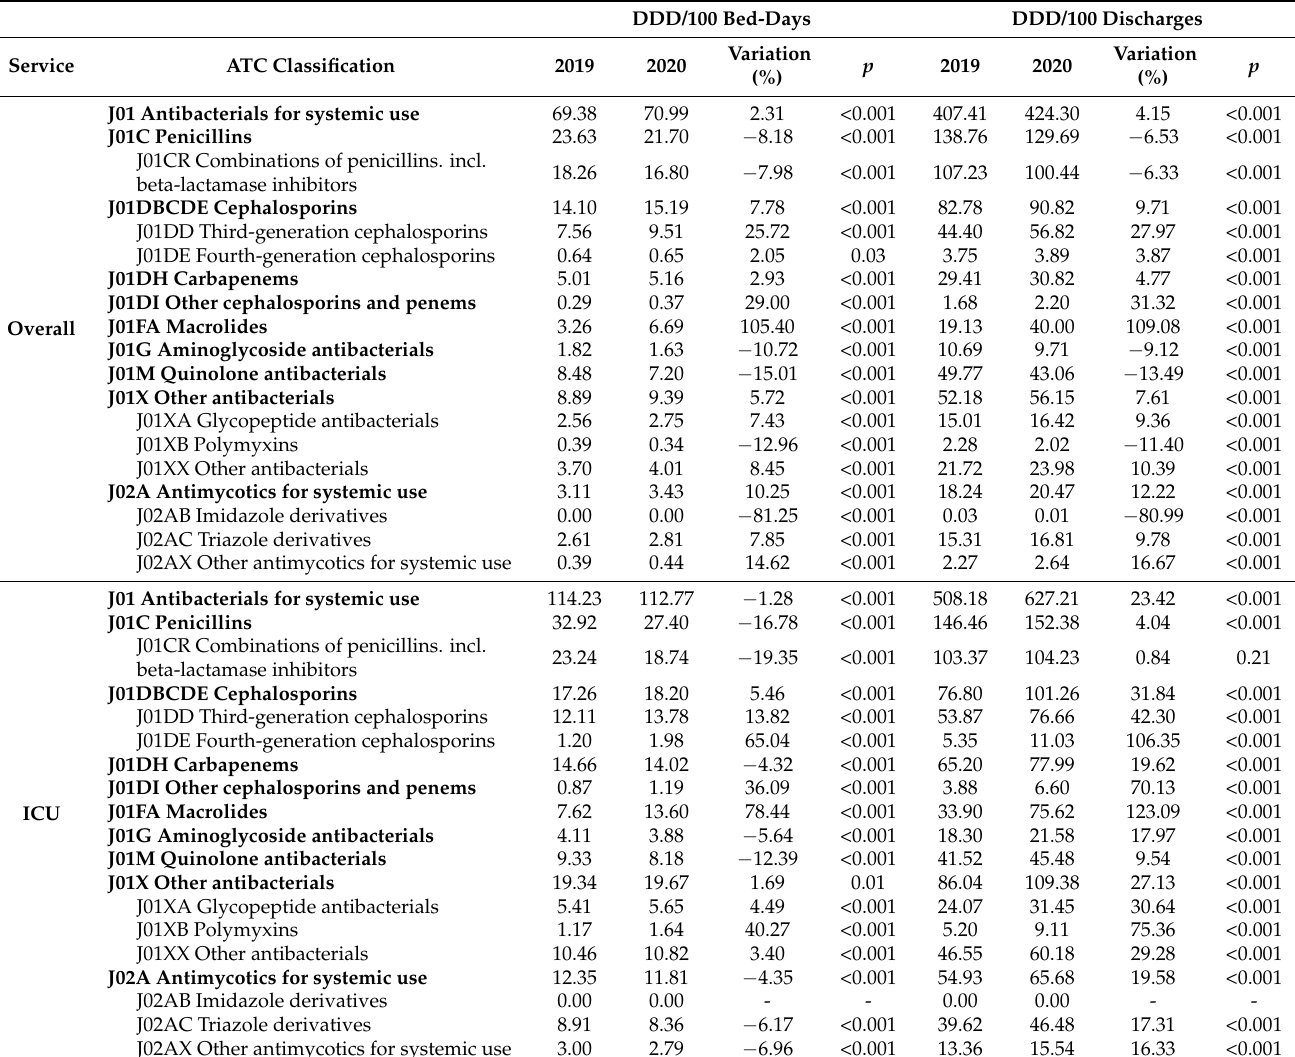
Table 1. Changes in overall and intensive care unit (ICU) consumption of anti-infectives for systemic use,